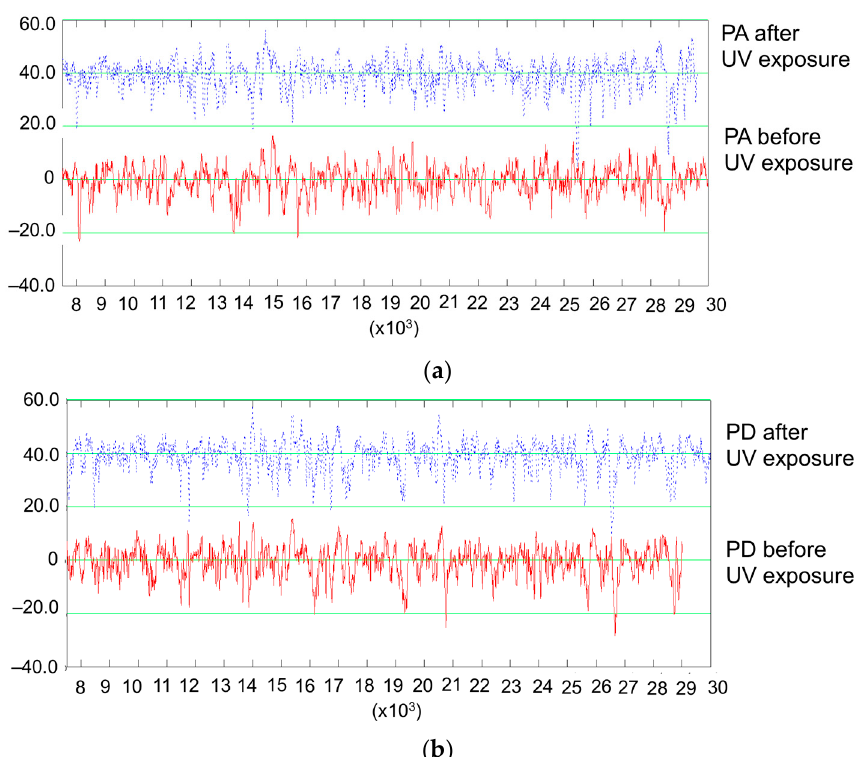
Figure 12. Comparisons of roughness profiles in the case of the PA and PD sycamore maple samples before and after UV exposure: ( a ) sample grade: PA; ( b ) sample grade: PD.